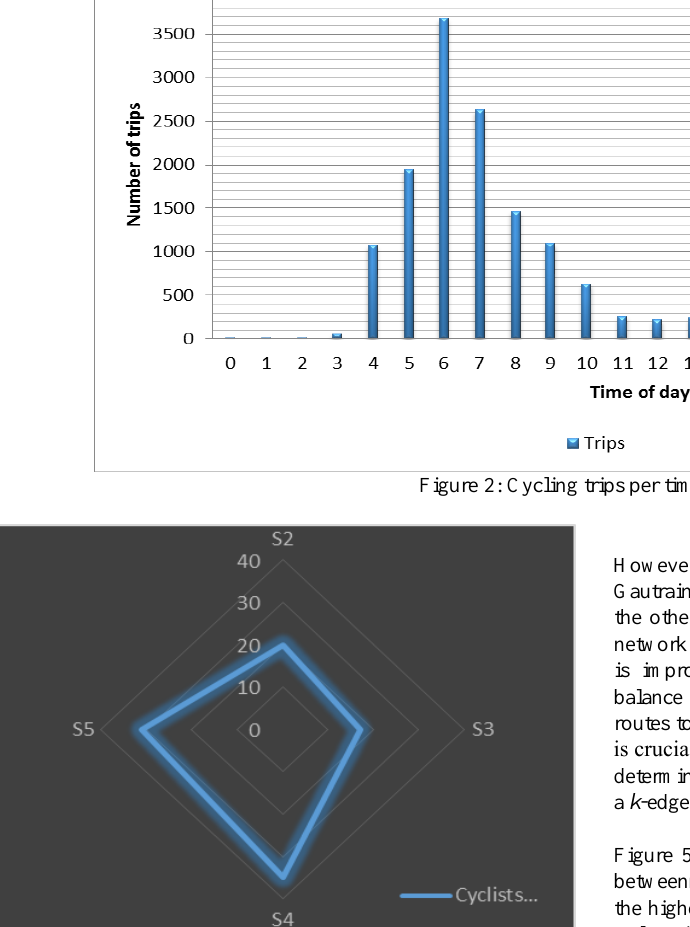
Figure 3: Cycling trips per Gaubus